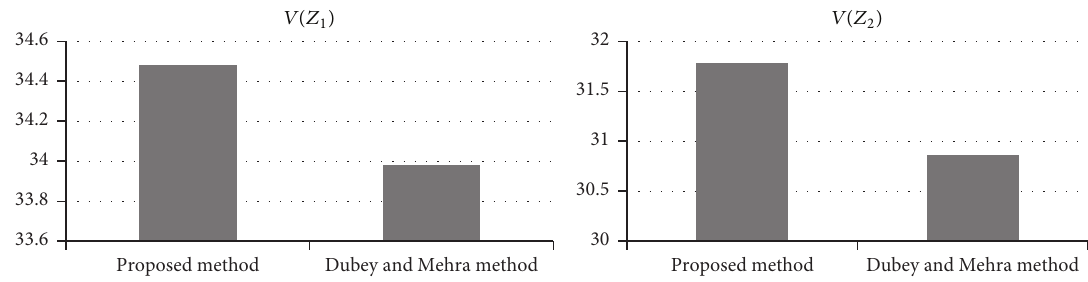
Figure 4: Comparison of